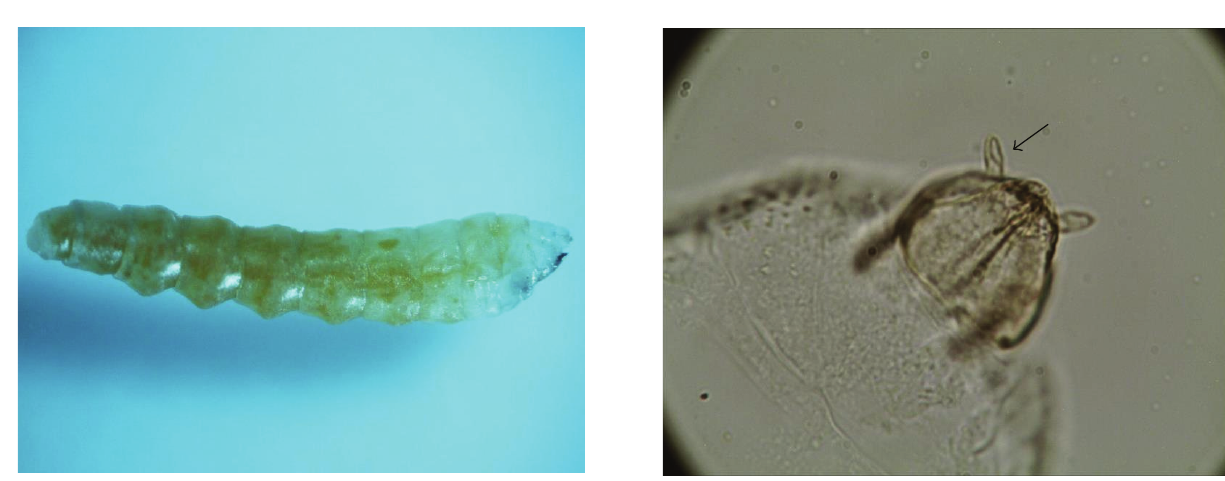
Figure 12: Head of the third instar. Arrow points to the placoid sensilla on the scape of the antenna.